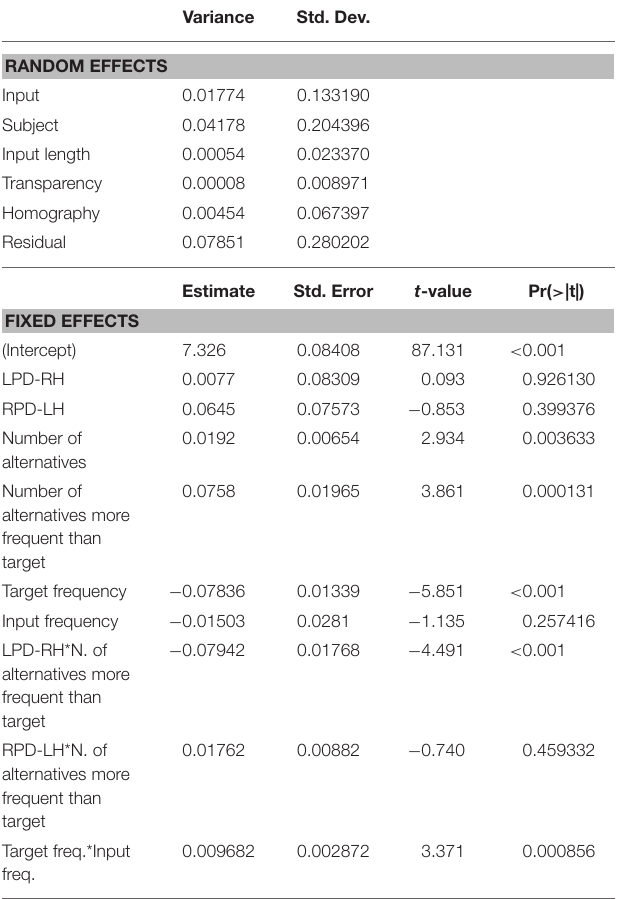
TABLE 4 | Mixed-effects model on (log-transformed) reaction times (RTs): random effects, estimates and t -values of fixed effects. Variance